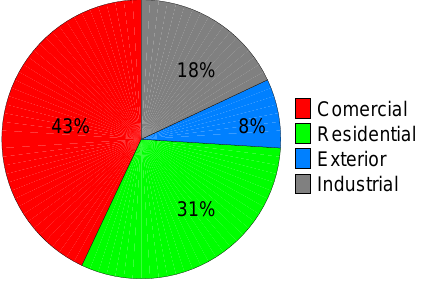
Figure 1. Distribution of world electricity consumption by